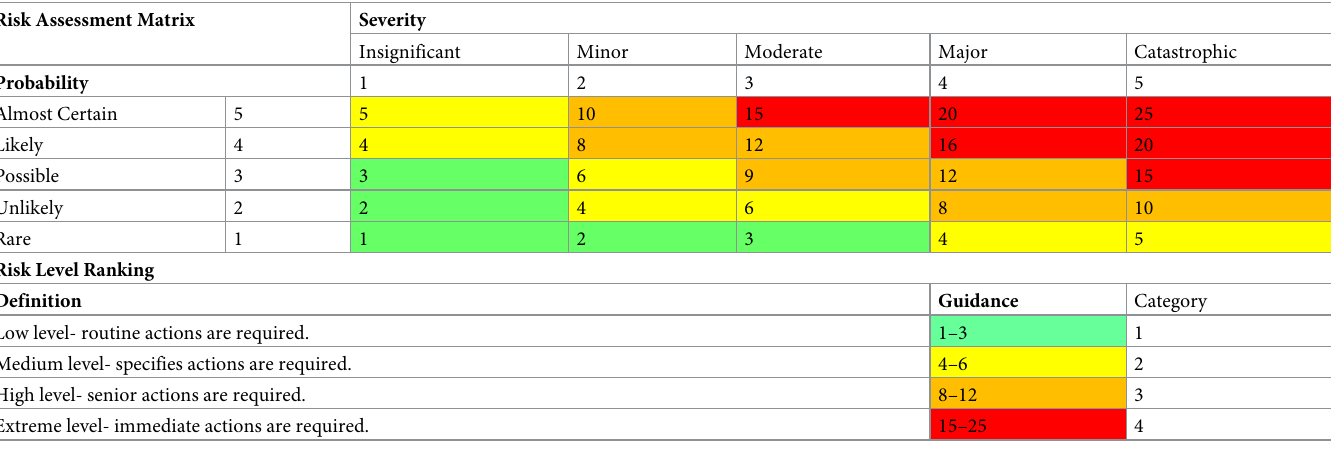
over keyword ð Þ þ temperature process parameter ð Þ ¼ over temperature deviation ð Þ According to ISO 14971 (2019) [27], risk consists of two dimensions, including proba- bility and severity (risk = probability × severity), in the risk assessment approach. There-